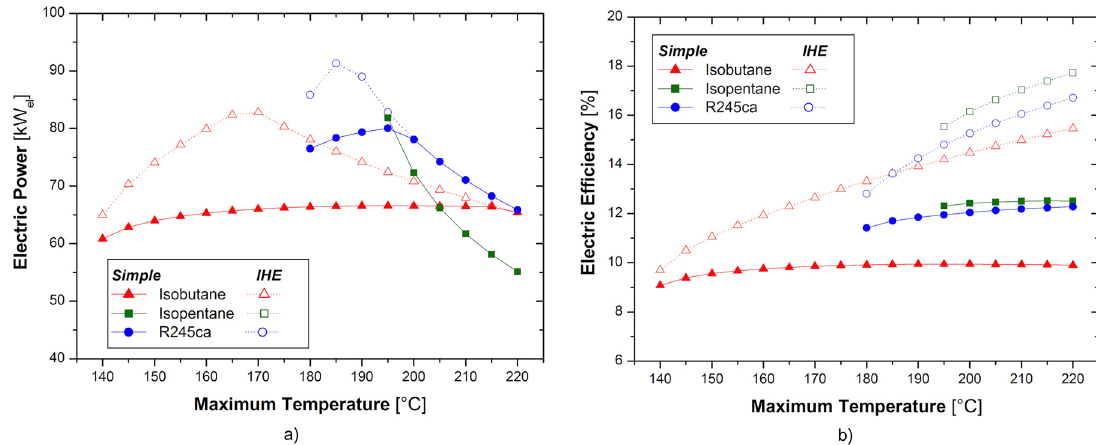
Figure 9. Effect of maximum temperature on ORC electric power ( a ) and electric efficiency ( b ) (transcritical cycle).